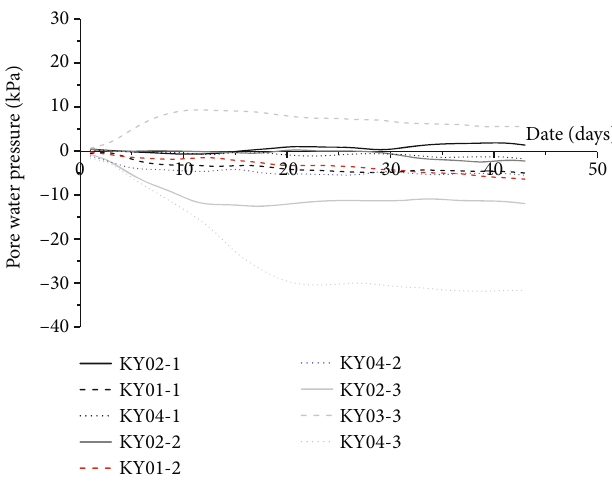
Figure 11: Time histories of pore water pressure at various monitoring